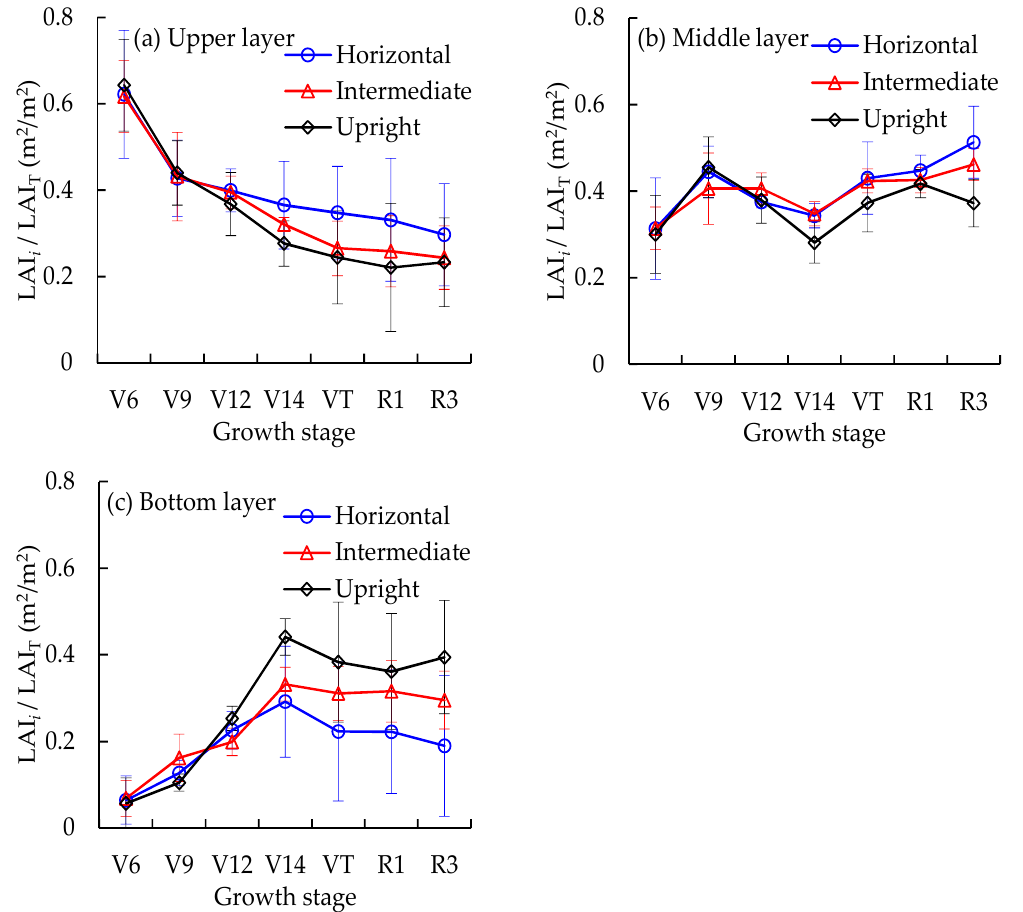
Figure 1. Comparison of the relative leaf area index (LAI) (LAI i /LAI T ) of the vertical canopy layers for different maize plant geometry types. LAI i /LAI T represents the ratio of the subtotal leaf area of a given layer (LAI i ) to the total LAI of the canopy (LAI T ). ( a ) Upper layer; ( b ) middle layer; ( c ) bottom layer. Error bars represent standard error of the mean.